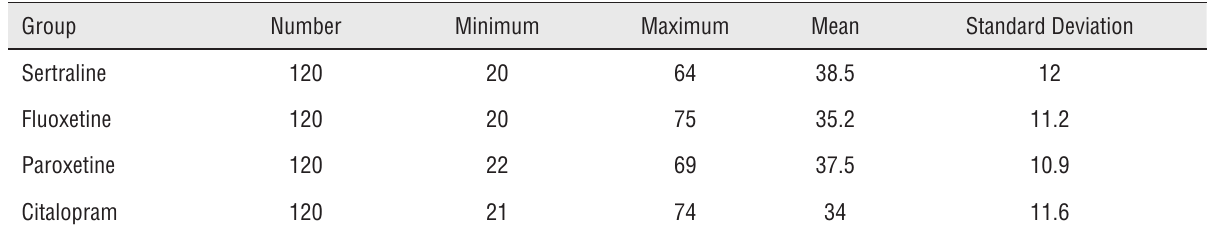
Table 1 - Mean age of